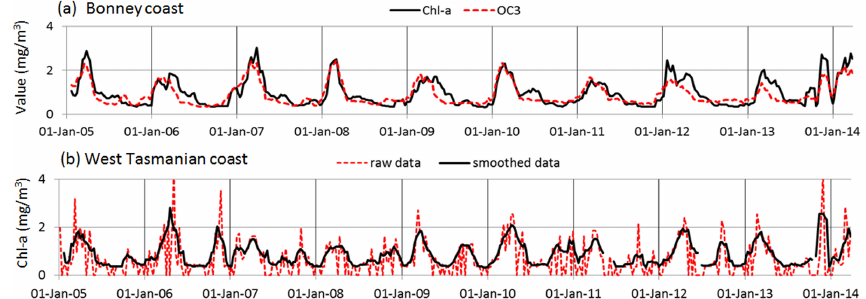
Figure 10. Reconstructed time series of chlorophyll a concentrations (solid lines) from normalised fluorescence line height (FLH) according to Eq. (2) for (a) the Bonney coast and (b) the western Tasmanian shelf for the period from 1 January 2005 to 31 March 2014. Shown are running mean averages over three successive data segments. The dashed line in panel (a) shows the corresponding OC3 data. The dashed line in panel (b) shows the raw 8-day composite data with zero values (ignored in the averaging procedure) being allocated to missing data. Data source: NASA (Giovanni).